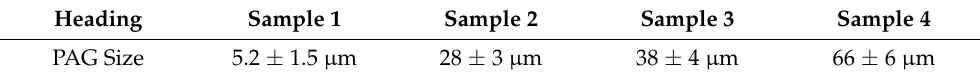
Figure 2. Optical images corresponding to ( a ) Sample 1 ( b ) Sample 2 ( c ) Sample 3 and ( d ) Sample 4. Table 2. Prior Auestenite Grain Sizes (PAGS) of samples after undergoing the heat treatments.